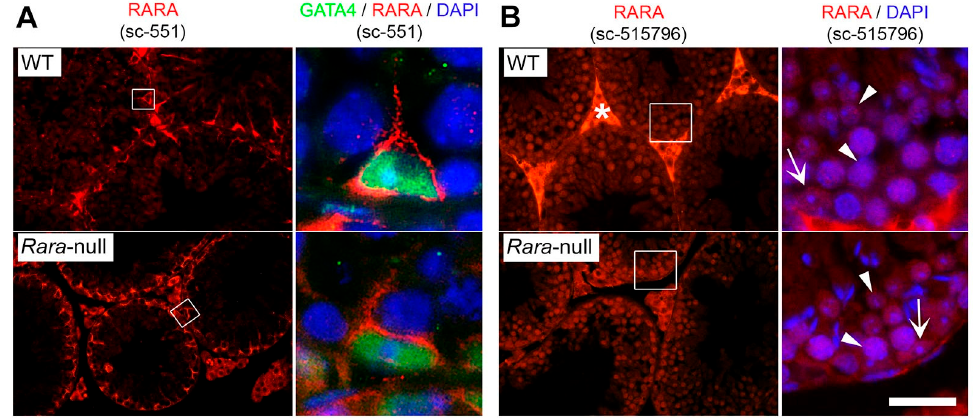
Figure 2. Two commercially available antibodies directed against RARA lacked specificity in IHC experiments. IHC analysis on histological sections of testes from 8-week-old wild-type (WT) and Rara -knockout mice ( Rara -null). ( A ) The sc-551 antibody recognized an epitope (red signal) which was distinct from RARA because it was similarly detected in the cytoplasm of Sertoli cells of WT and Rara -null mice. Sertoli cell nuclei were identified by using an antibody directed against the GATA4 transcription factor (green signal). ( B ) The sc-525796 antibody recognized a nuclear epitope (red signal) which was distinct from RARA because it was detected in the nuclei of germ cells (arrowheads) and Sertoli cells (arrows) of WT and Rara -null mice. The right panels show enlargements of the boxes in the left panels. Nuclei were counterstained with DAPI (blue signal). Star indicates interstitial signal due to the use of a mouse monoclonal antibody. Scale bar: 80 μ m for left panels; 20 μ m for right panels.